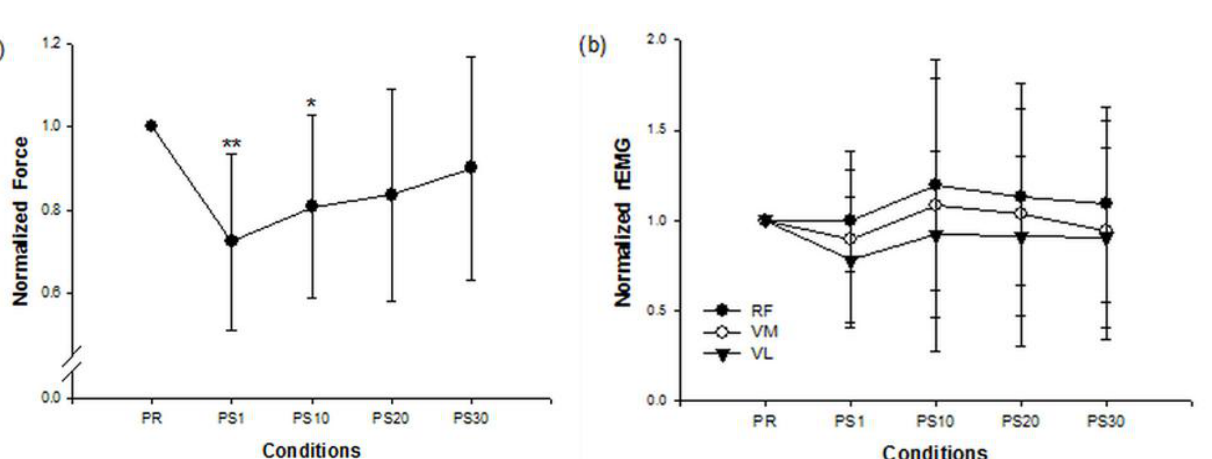
Figure 2. Force ( a ) and root-mean-square EMG (rEMG) ( b ) data were presented as relative values. Both have been normalized with respect to the reference values recorded during pre-fatigue isometric maximal voluntary contraction (MVC) (PR). The diagram showed the changes of the normalized force and rEMG during post-fatigue MVCs at 1 min (PS1), 10 min (PS10), 20 min (PS20) and 30 min (PS30) after stepping exercise. Normalized force and rEMG of VM and VL dropped shortly after stepping exercise and progressively recovered after 10 min. Asterisks showed the significant difference between conditions ( * p < 0.05 ; ** p< 0.01